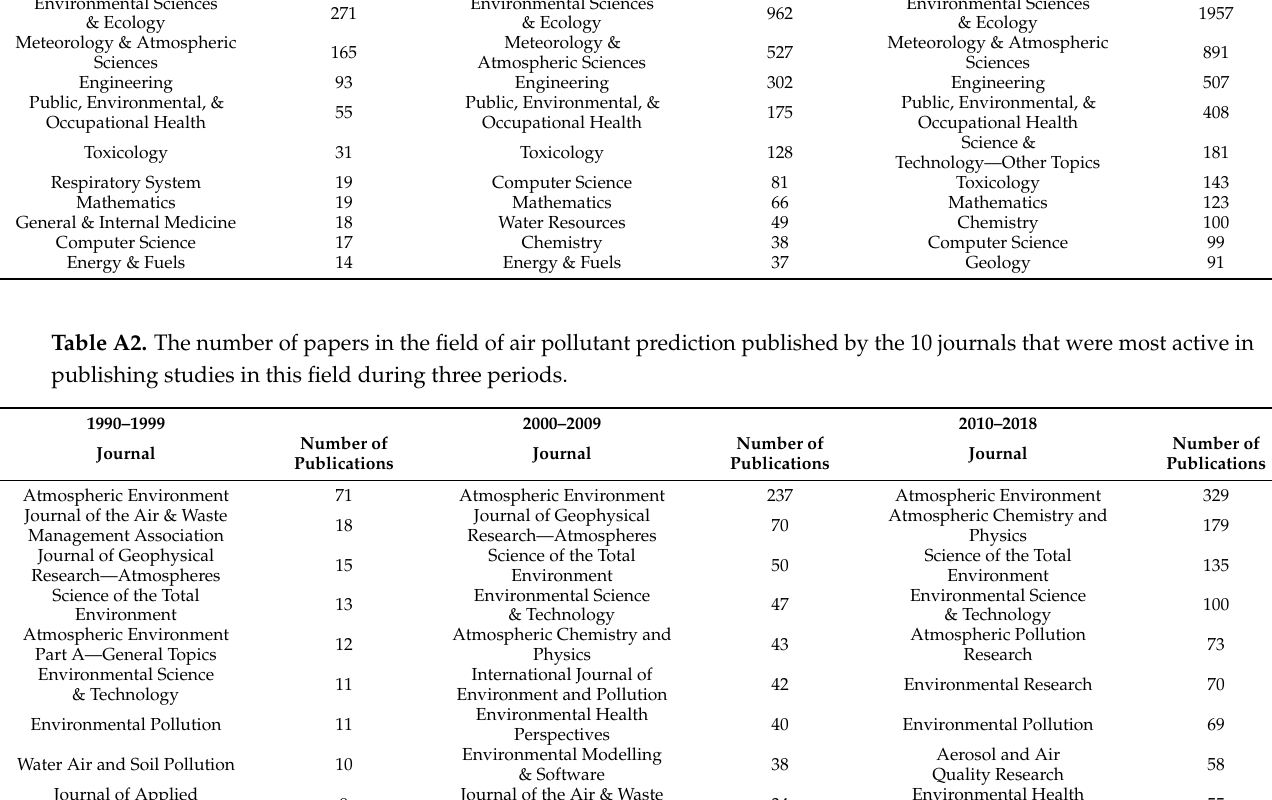
Table A1. The number of publications in the field of air pollutant prediction in the 10 disciplines that were most active in publishing studies in this field during three periods.